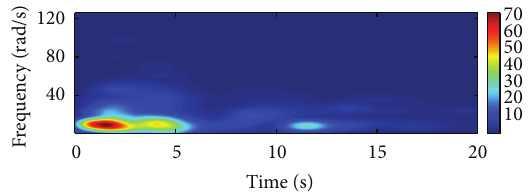
Figure 2: EPSD of the El-Centro seismic ground motion.